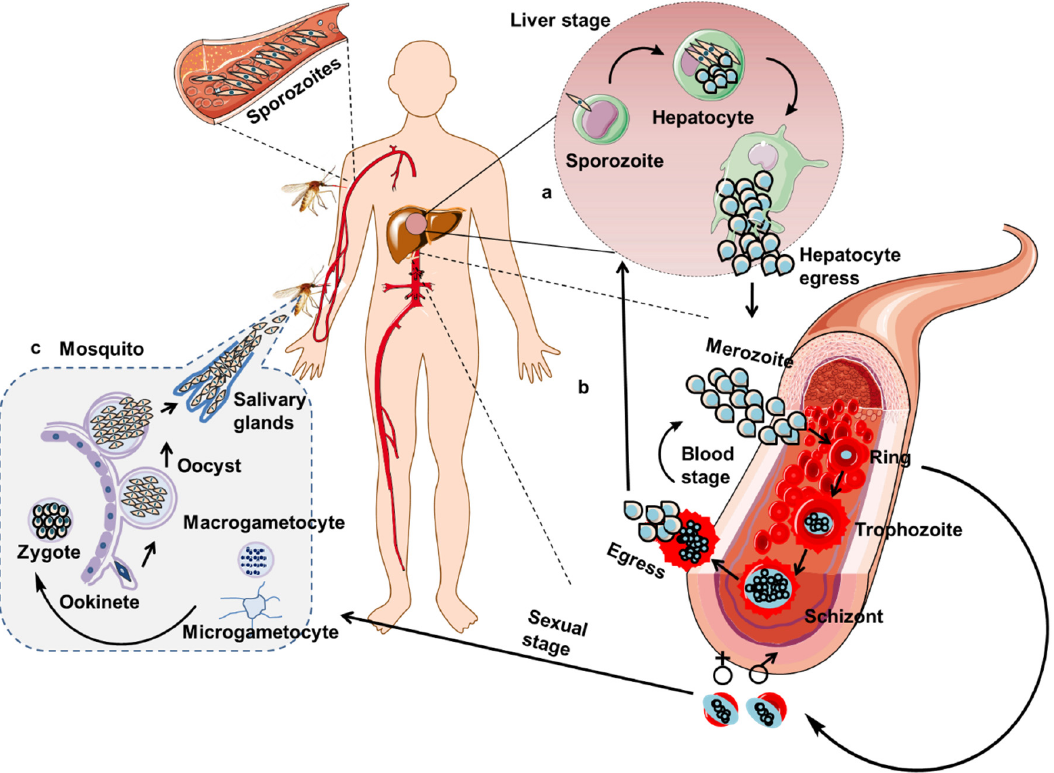
Figure 1. Complex life cycle of P. falciparum . The life cycle has 3 stages: the pre-erythrocytic and erythrocytic stages in humans (host) and sexual process in the mosquito vector. a |Pre-erythrocytic stage. b |Erythrocytic stage. c |Mosquito/sexual stage.